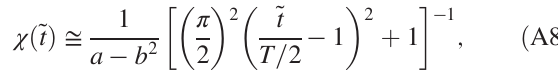
FIG. 10. Potential F ð x Þ versus x in Eq. (A1) in the following cases. (a) The coefficient a > a c ≡ b 2 , F 0 ð x Þ < 0 at any x